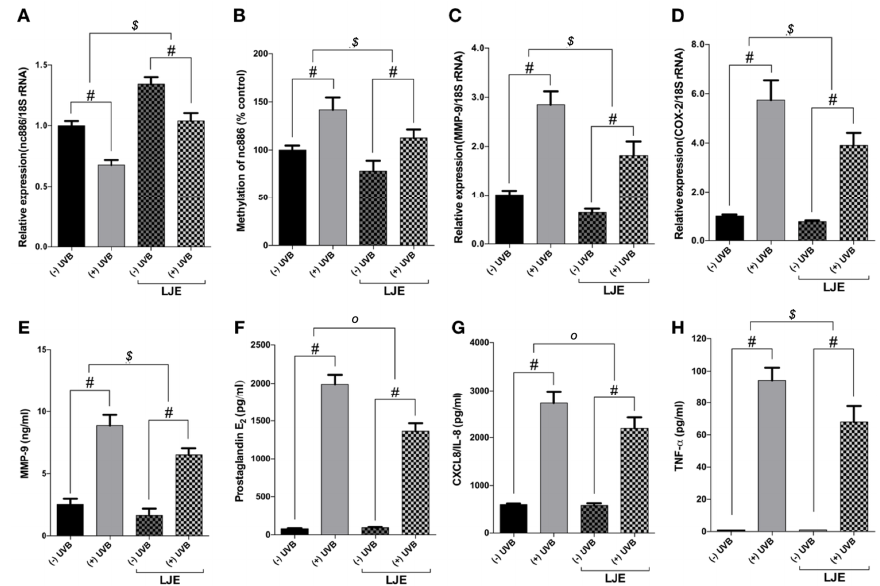
Figure 3. Effect of Laminaria japonica extract (LJE) on the production of inflammation-related proteins increased by UVB. The cells were treated with LJE at a concentration of 100 µg/mL for 48 h prior to UVB irradiation (5 mJ/cm 2 ). After 24 h of irradiation, RNA, gDNA samples, and cell culture fluid were collected. mRNA and gDNA samples were analyzed with qRT-PCR. A fold change was used to compare nc886 ( A expression and ( B ) methylation, ( C ) MMP-9, and ( D ) COX-2 to the control. The measured values for ( E ) MMP-9, ( F ) PGE 2 , ( G ) IL-8, and ( H ) TNF- α were indicated in an absolute concentration for each. * p < 0.05, # p < 0.01, compared to basal levels; o p < 0.05, $ p < 0.01, compared between ( − ) LJE and ( + ) LJE groups. Nutrients 2020 , 12 , 1958